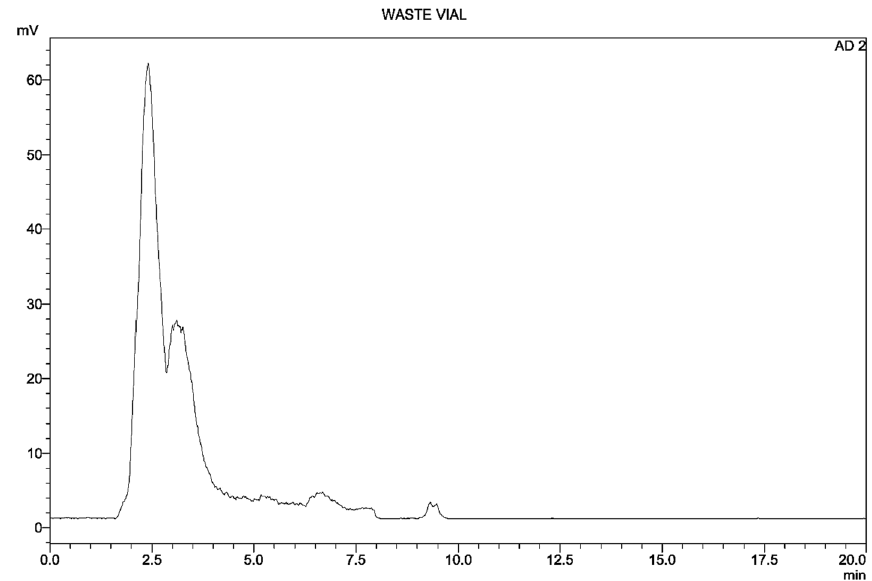
Fig. 7 Radio-HPLC chromatogram of the waste vial